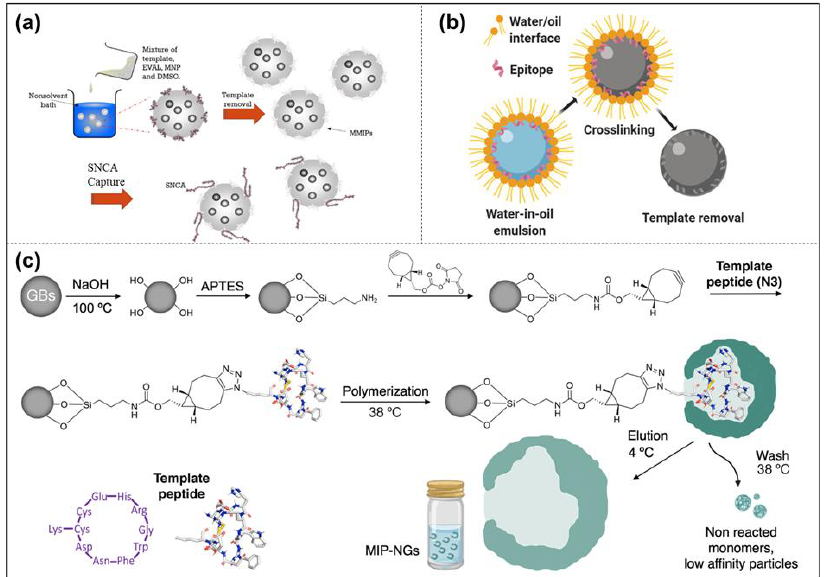
Figure 5. Methods of epitope imprinting. The protocols of epitope imprinting via precipitation polymerization ( a ) inverse emulsion polymerization ( b ); and solid-phase synthesis ( c ). Reprinted with permission from Ref. [45,70,71]. Copyright 2022, MDPI; 2020, Wiley; 2021, Wiley.